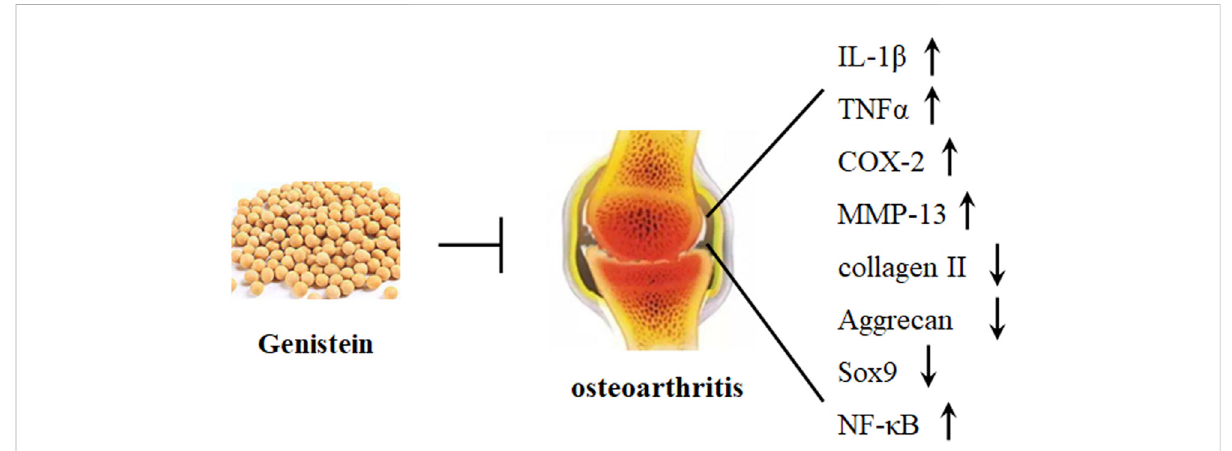
FIGURE 3 Genisteinprotectsagainstosteoarthritisdevelopment.Genisteincansigni fi cantly decrease theexpressionofIL-1 β ,TNF α ,COX-2,MMP-13,and NF- κ B and increase the expression of Sox9, collagen II, and aggrecan in